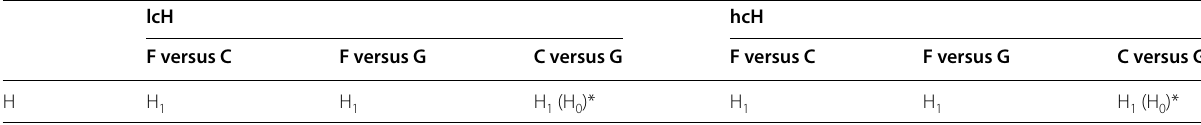
Table 7 Test of significance ( χ 2 ) of lcH and hcH taken from forest (F)-, crop (C)- and grassland (G) mineral top soil samples